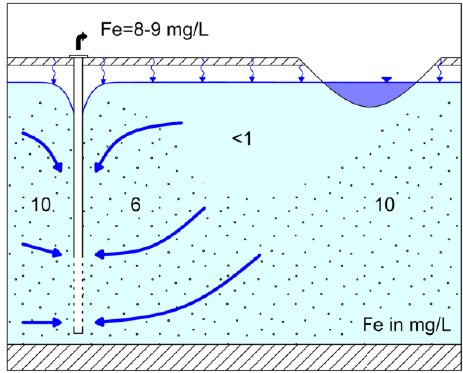
Figure 4. Case B – Infiltration of river water resulting low iron conc. in bank filtrate. Figure 4. Case B—Infiltration of river water resulting low iron conc. in bank